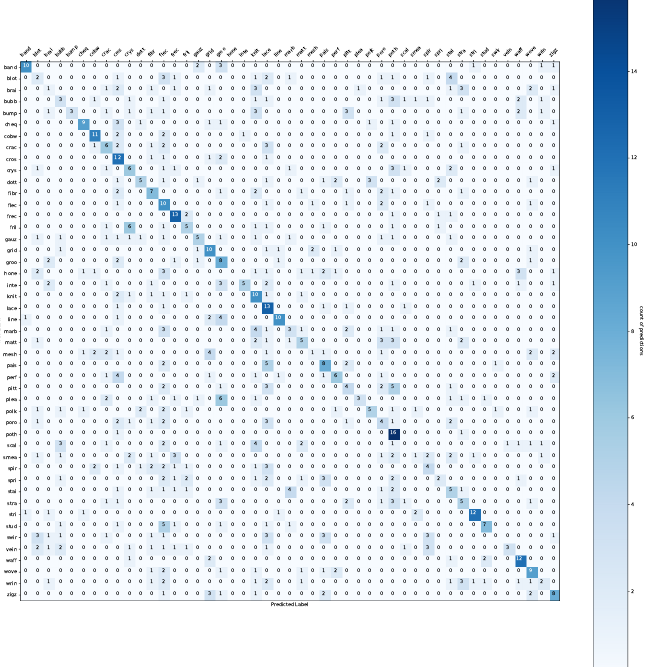
Figure A4. Experiment 1 with SGD Optimizer—the confusion matrix correlates with the best model (DWTaP) obtained for the DTD dataset.